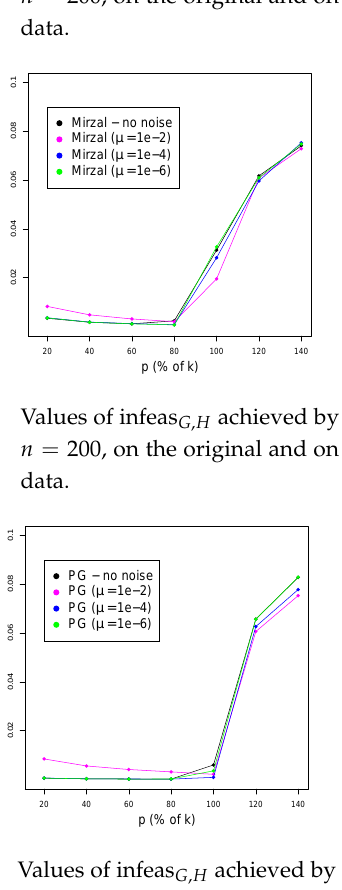
Values of infeas G , H achieved by Algorithm 3 for Values of RSE for Algorithm 3 for n = 200, for the n = 200, on the original and on the noisy BION original and the noisy BION data. data. Figure 5. On the left, we depict how RSE is changing with increasing the inner dimension p from 20% of real inner dimension k to 140% of k . For each algorithm, we depict RSE on the original BION data and on the noisy BION data with µ ∈ { 10 − 2 ,10 − 4 ,10 − 6 } . On the right plots, we demonstrate how (in)feasible are the optimum solutions obtained by each algorithm, for different relative inner dimensions p , for the original and the noisy BION data. On the noisy dataset, we also demonstrate what happens if the internal dimension is larger than the true internal dimension (this is demonstrated by p = 120%, 140% )